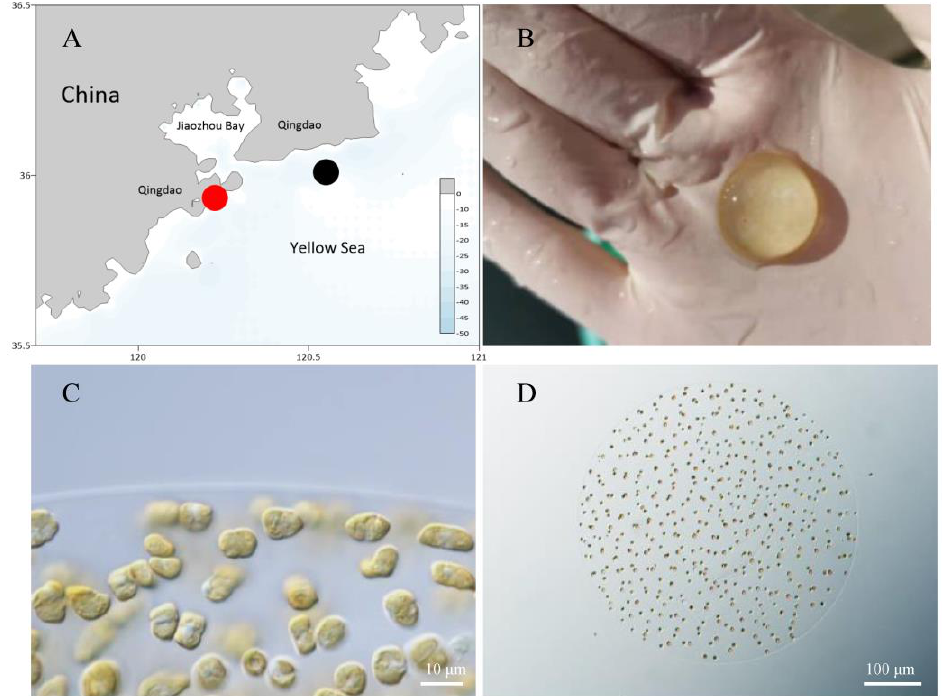
Figure 1. Geographical locations of sampling sites and morphological characteristics of P. globosa colonies. ( A ) Geographical locations of the sampling sites for field samples: red circle: the sampling site in this study; black circle: the sampling site at which P. globosa was sampled outside of the Jiaozhou Bay in January 2019. ( B ) A P. globosa colony. ( C ) A portion of a P. globosa colony under a light microscope, with P. globosa cells observable. ( D ) Morphological characteristics of a small-sized P. globosa colony under a light microscope.